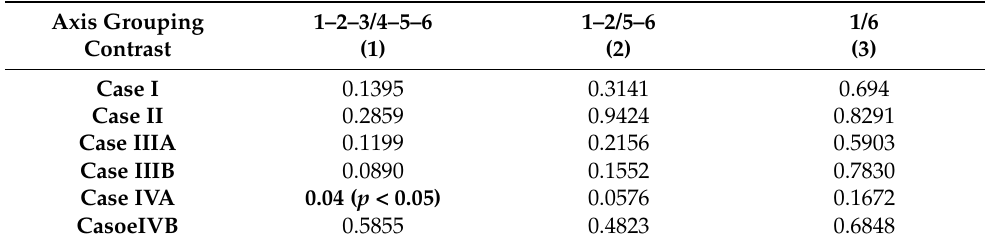
Table 6. Significance of orthogonal contrasts of RH